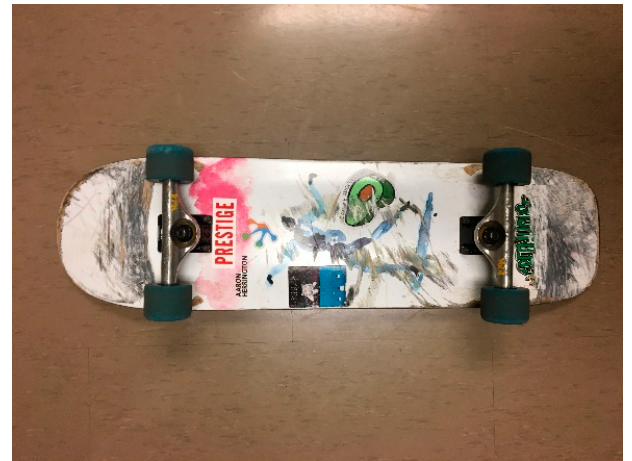
Figure 1. Skateboard Top View.